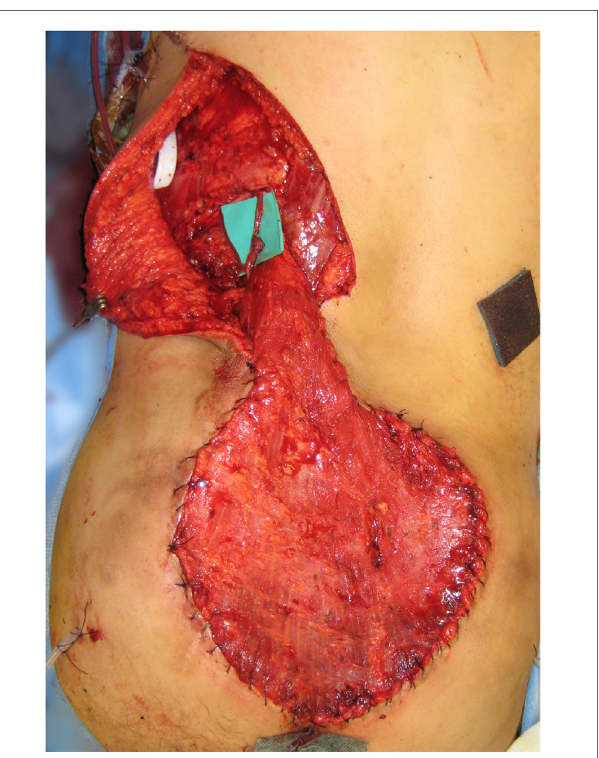
FigUre 9 | Free latissimus dorsi muscle only flap inset into the defect .